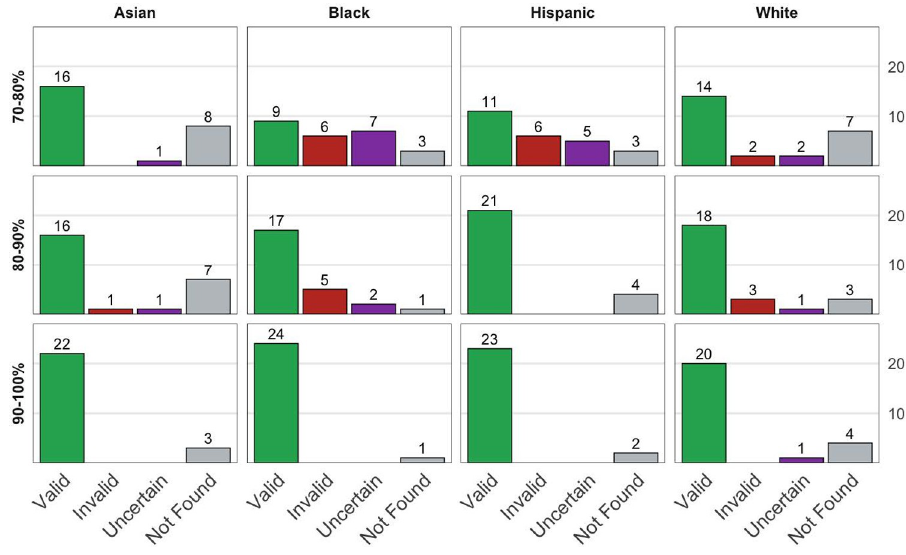
Fig 1. Manual validation of racial